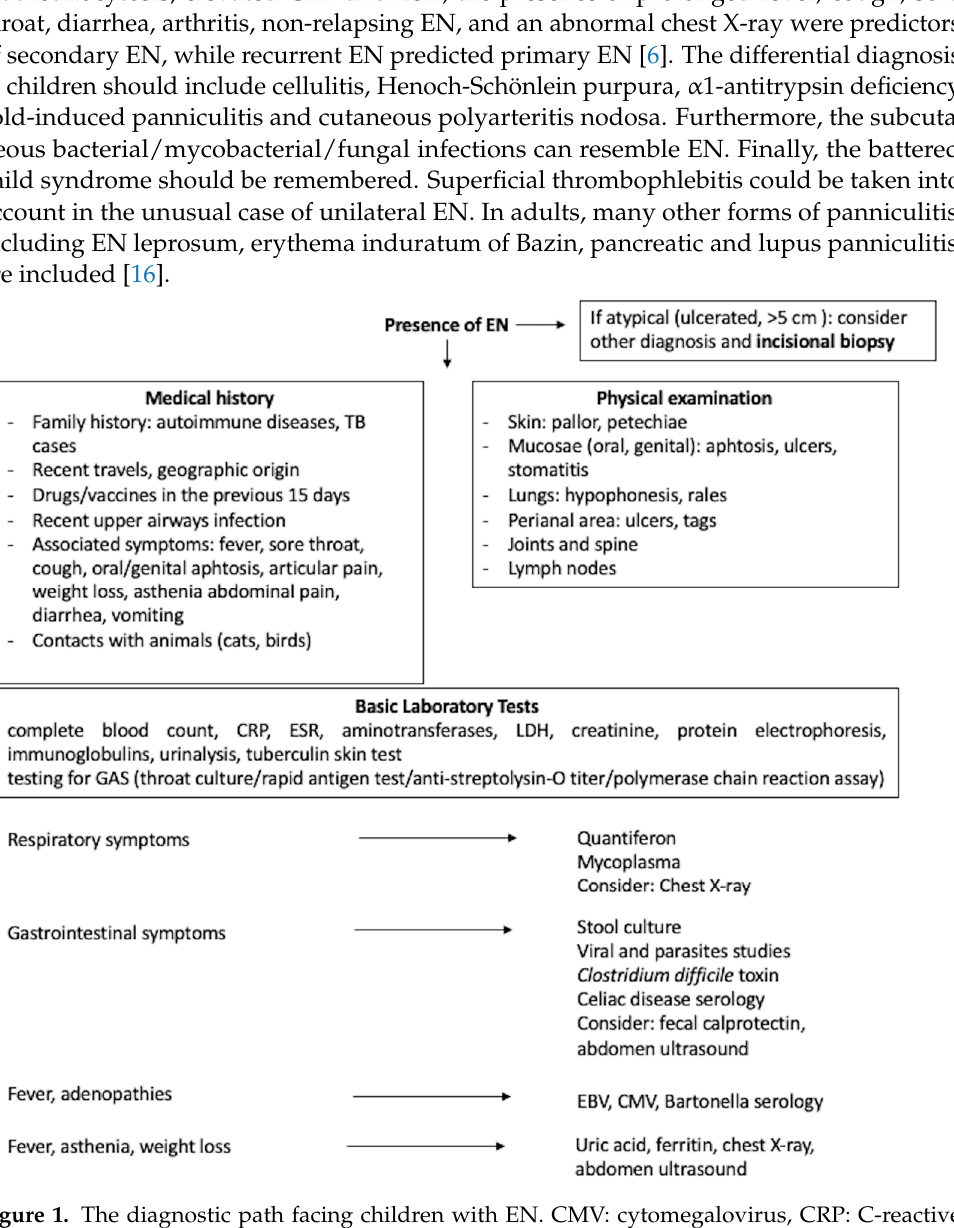
Figure 1. The diagnostic path facing children with EN. CMV: cytomegalovirus, CRP: C-reactive protein, EBV: Epstein–Barr virus, EN: erythema nodosum, ESR: erythrocyte sedimentation rate, GAS: Group A β -hemolytic Streptococcus, LDH: lactate dehydrogenase, TB: tuberculosis.